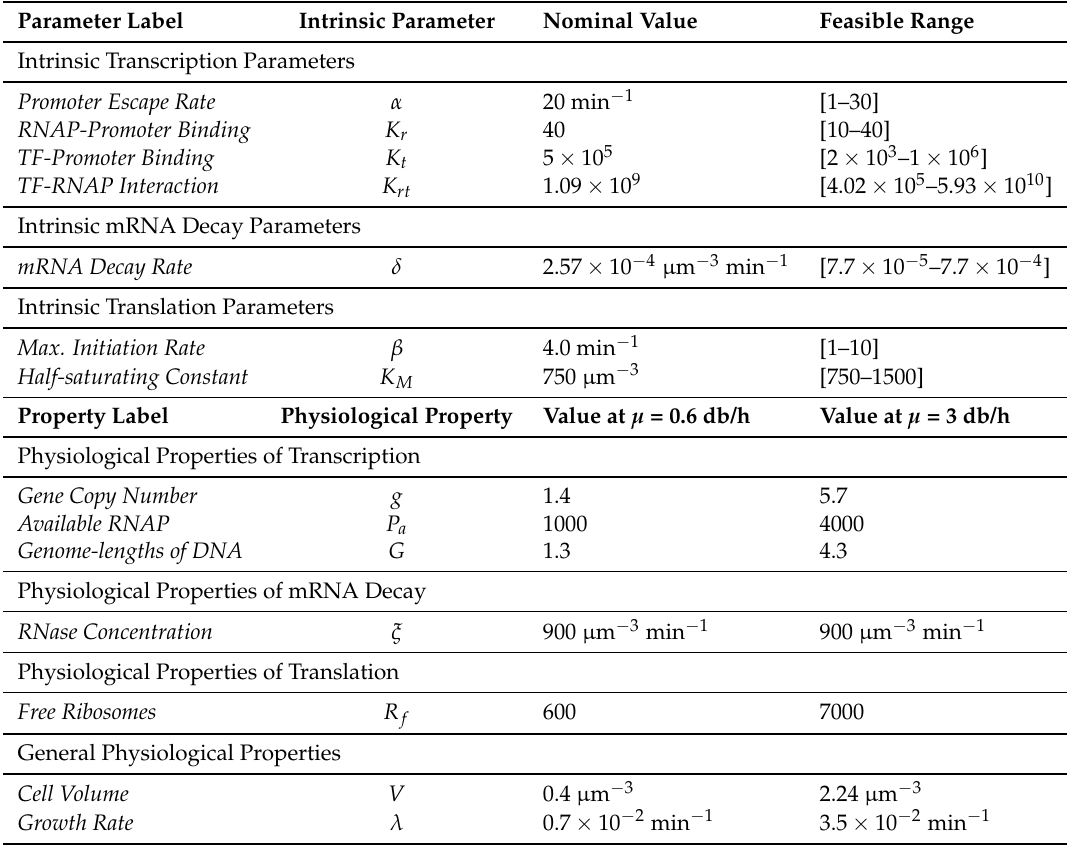
Table 1. Summary of Intrinsic and Physiological